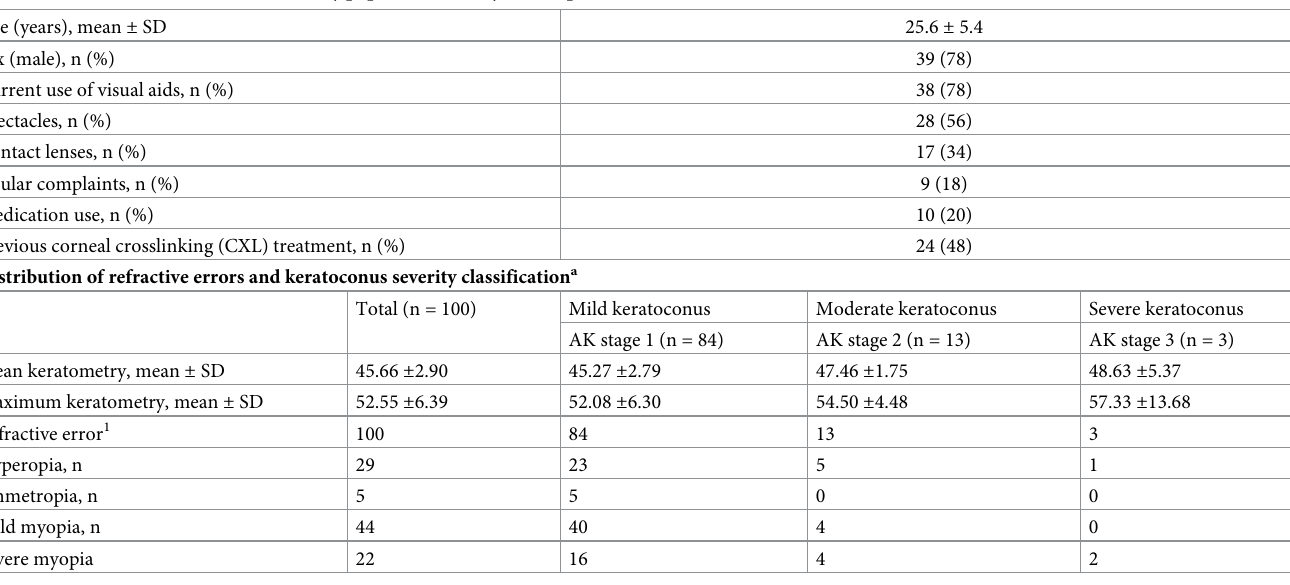
Table 1. Clinical characteristics of the study population (100 eyes of 50